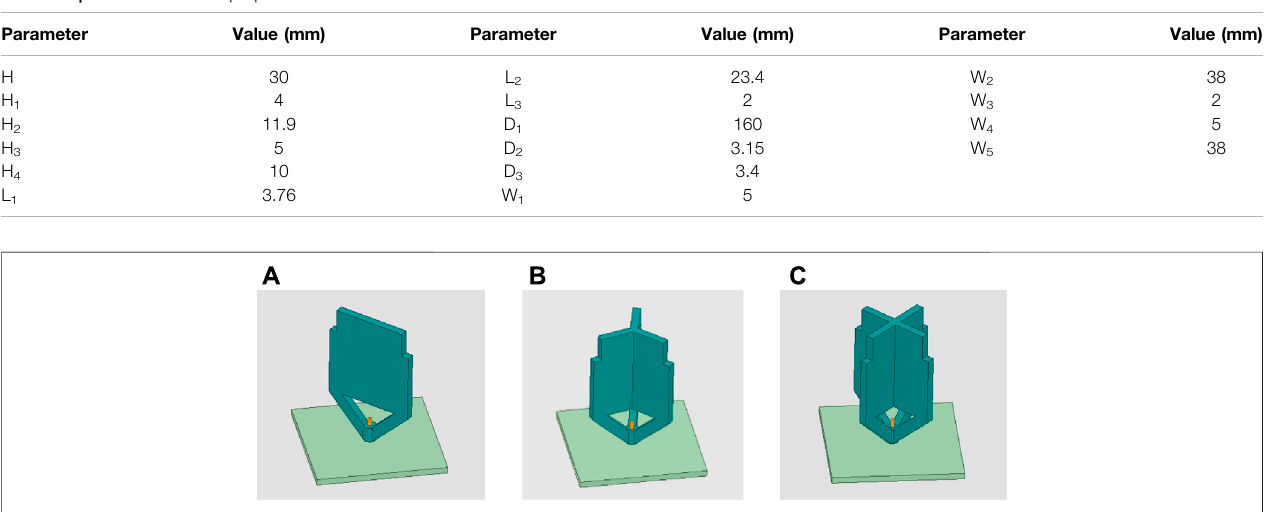
FIGURE 2 | Monopoles with different sector number N: (A) N = 2, (B) N = 3, and (C) N = 4.